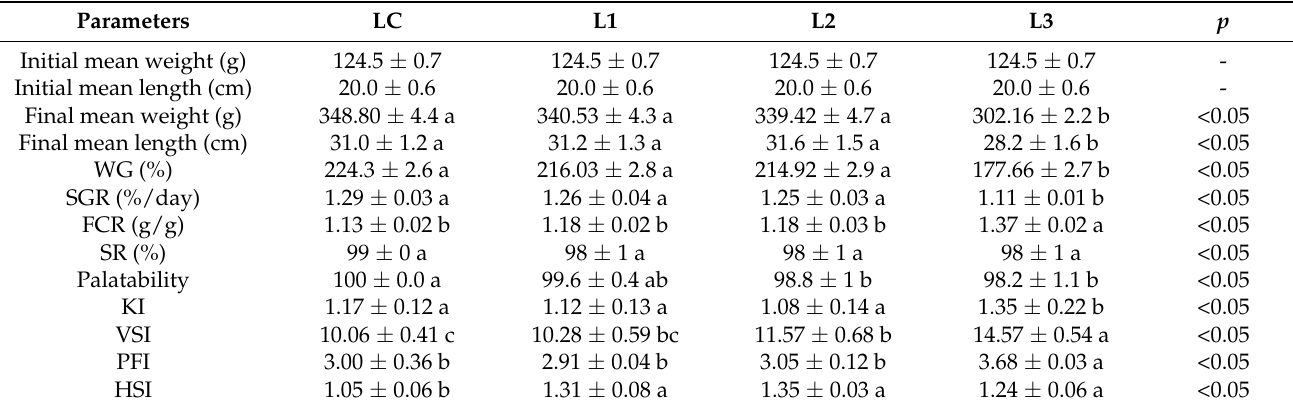
Productive performances of rainbow trout fed with different experimental diets (mean ± standard